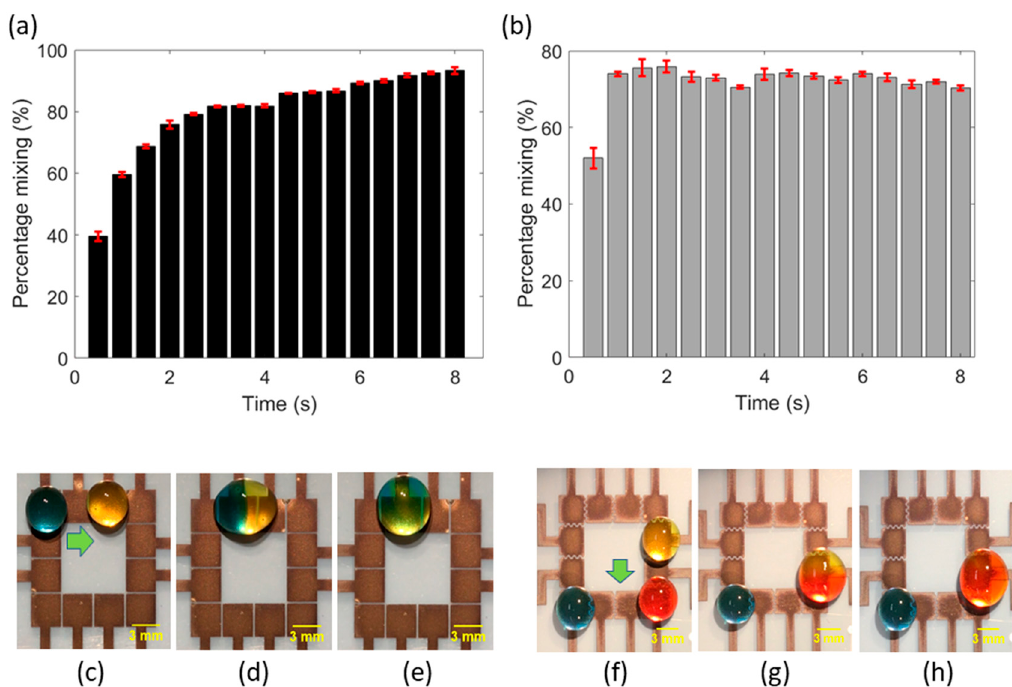
Figure 3. ( a ) Percentage mixing versus time for mixing of blue and yellow droplets as calculated from the relative mixing index. ( b ) Percentage mixing versus time for mixing of yellow and red droplets as calculated from the relative mixing index. The error bars indicate standard deviations. ( c ) Position of blue and yellow droplets at time (t) = 10.6 s on interdigitated electrode configuration. The initial volume of both the droplets is 30 μ L. ( d ) The blue droplet moves towards the yellow droplet and starts merging with it (t = 10.7 s). ( e ) Mixing of blue and yellow droplet yields a green-colored droplet (t = 18 s). ( f ) Position of yellow and red droplets at t = 5.4 s on square electrode configuration. The initial volume of both the droplets is 30 μ L. ( g ) Yellow droplet moves towards the red droplet and starts merging with it (t = 5.7 s). ( h ) Yellow and red droplets mix with each other to yield a single droplet (t = 13 s).